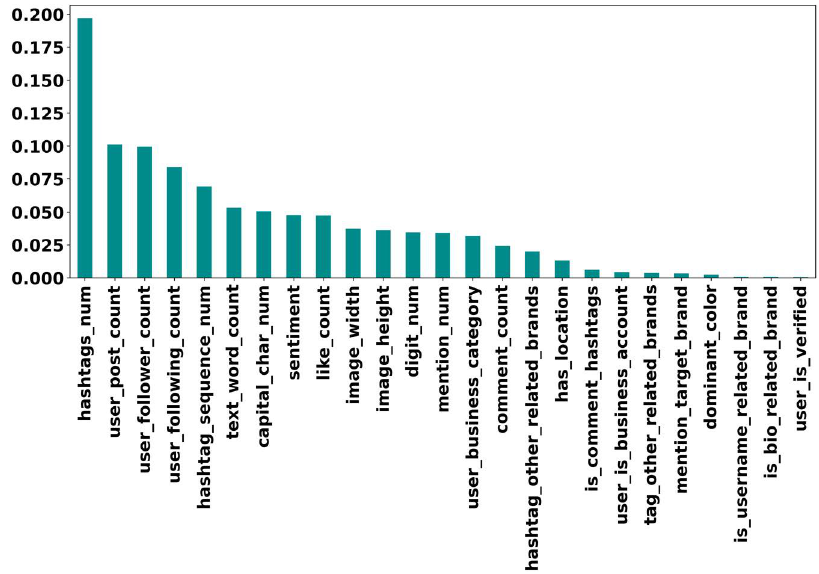
Figure 12. The feature importance of the collected features using Random